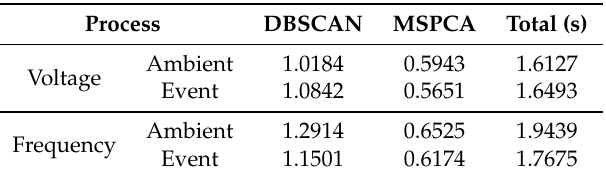
Table 6. Computation time